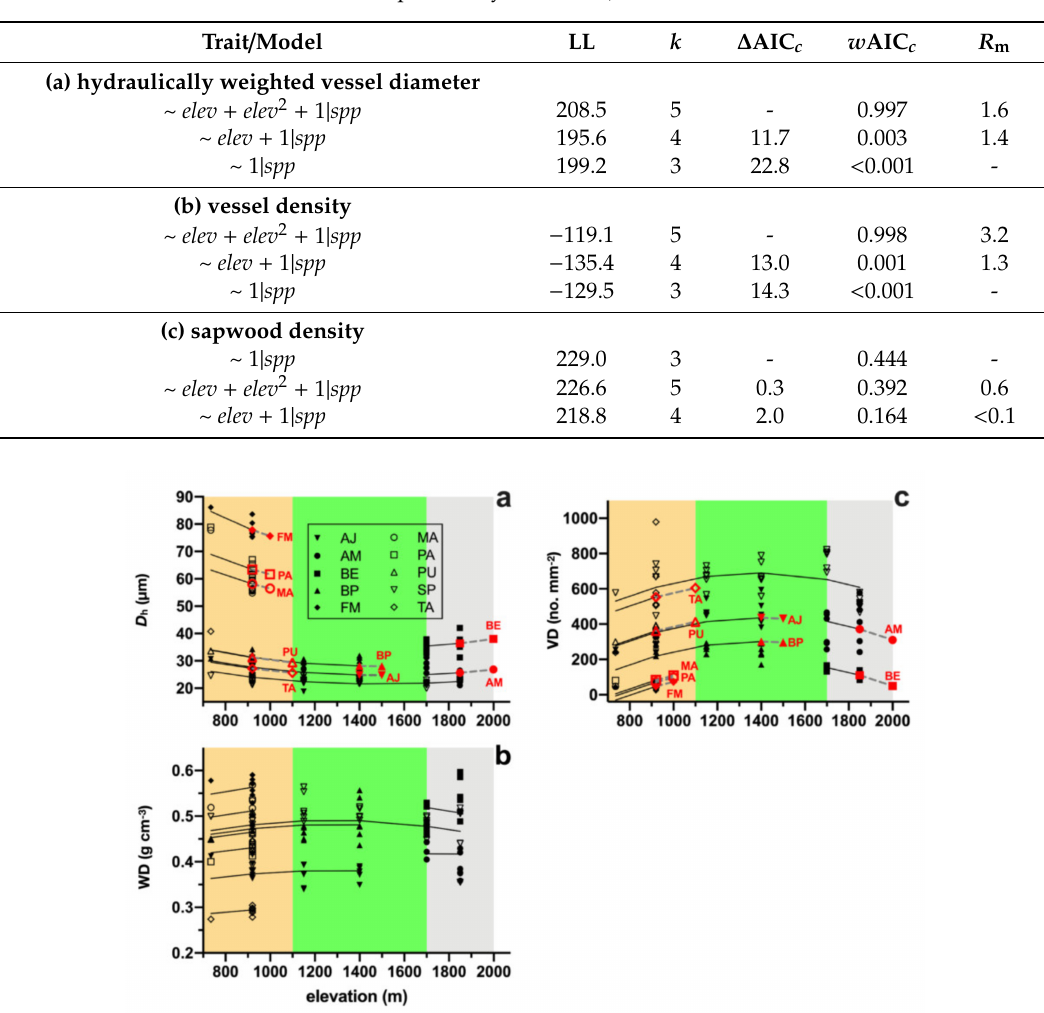
Table 4. Information-theoretic ranking of candidate models for each of the three functional traits tested: ( a ) hydraulically weighted vessel diameter, ( b ) vessel density, and ( c ) sapwood density. Shown are the three models contrasted per trait, where elevation ( elev ) is applied as a second-order polynomial, a linear change, or no relationship (intercept-only model). All models include a random species e ff ect (1 | spp ). Also shown for each model are the log-likelihoods (LL), number of estimated model parameters ( k ), the di ff erence in Akaike’s information criterion (corrected for small samples) between the current and top ranked model ( ∆ AIC c ), the model probability ( w AIC c ), and the marginal R 2 ( R m ; contribution of fixed e ff ects to the total variance explained by the model).